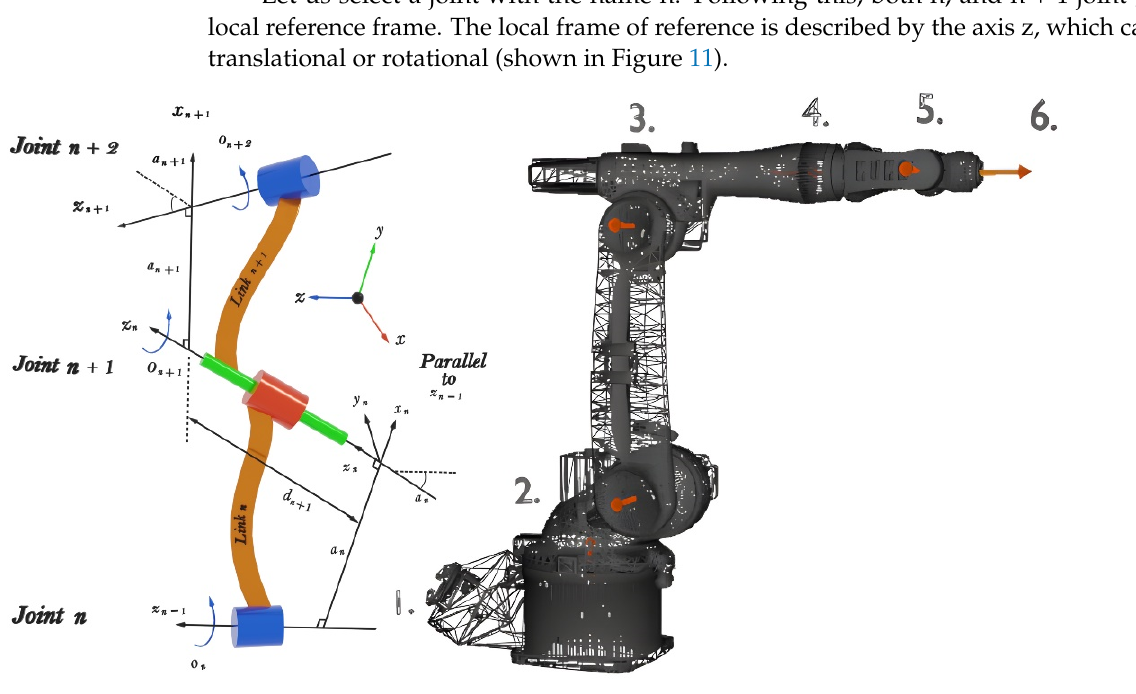
Figure 11. Designed virtual user interface. Symbols used in the DH table have predefined meanings, which are as follows: θ : Rotation along Z axis; d: Movement along Z axis (distance); a: Joint offset (length of normal); α : Angle difference of two consecutive joints (joint twist) [52].